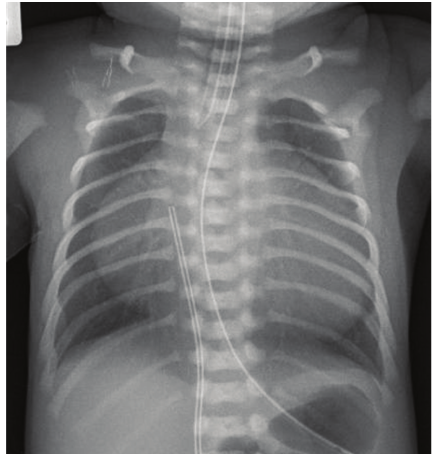
Figure 1: Proband’s chest film on day 1 of life. This film shows massive cardiomegaly, thin and wavy upper ribs, and the bilateral anomalous